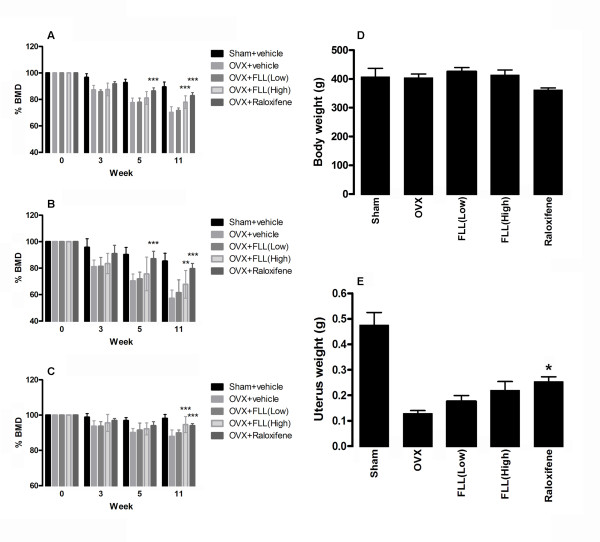
Mean of percentage difference of BMD compared with week 0 in lumbar spine between the baseline (week 3, before ovariectomized), week 0 (ovariectomized) and week 8 after treatments. (A) Total BMD; (B) trabecular BMD; (C) cortical BMD of lumbar spine were illustrated. The error bar represents the SD. Significant difference: * P < 0.05; ** P < 0.01; *** P < 0.001 for difference from OVX group without treatment. (Note: all groups were started from 100% at week 3.) (D) The body and (E) the uterus wet weight of different treatment groups were measured at the end of experiment.